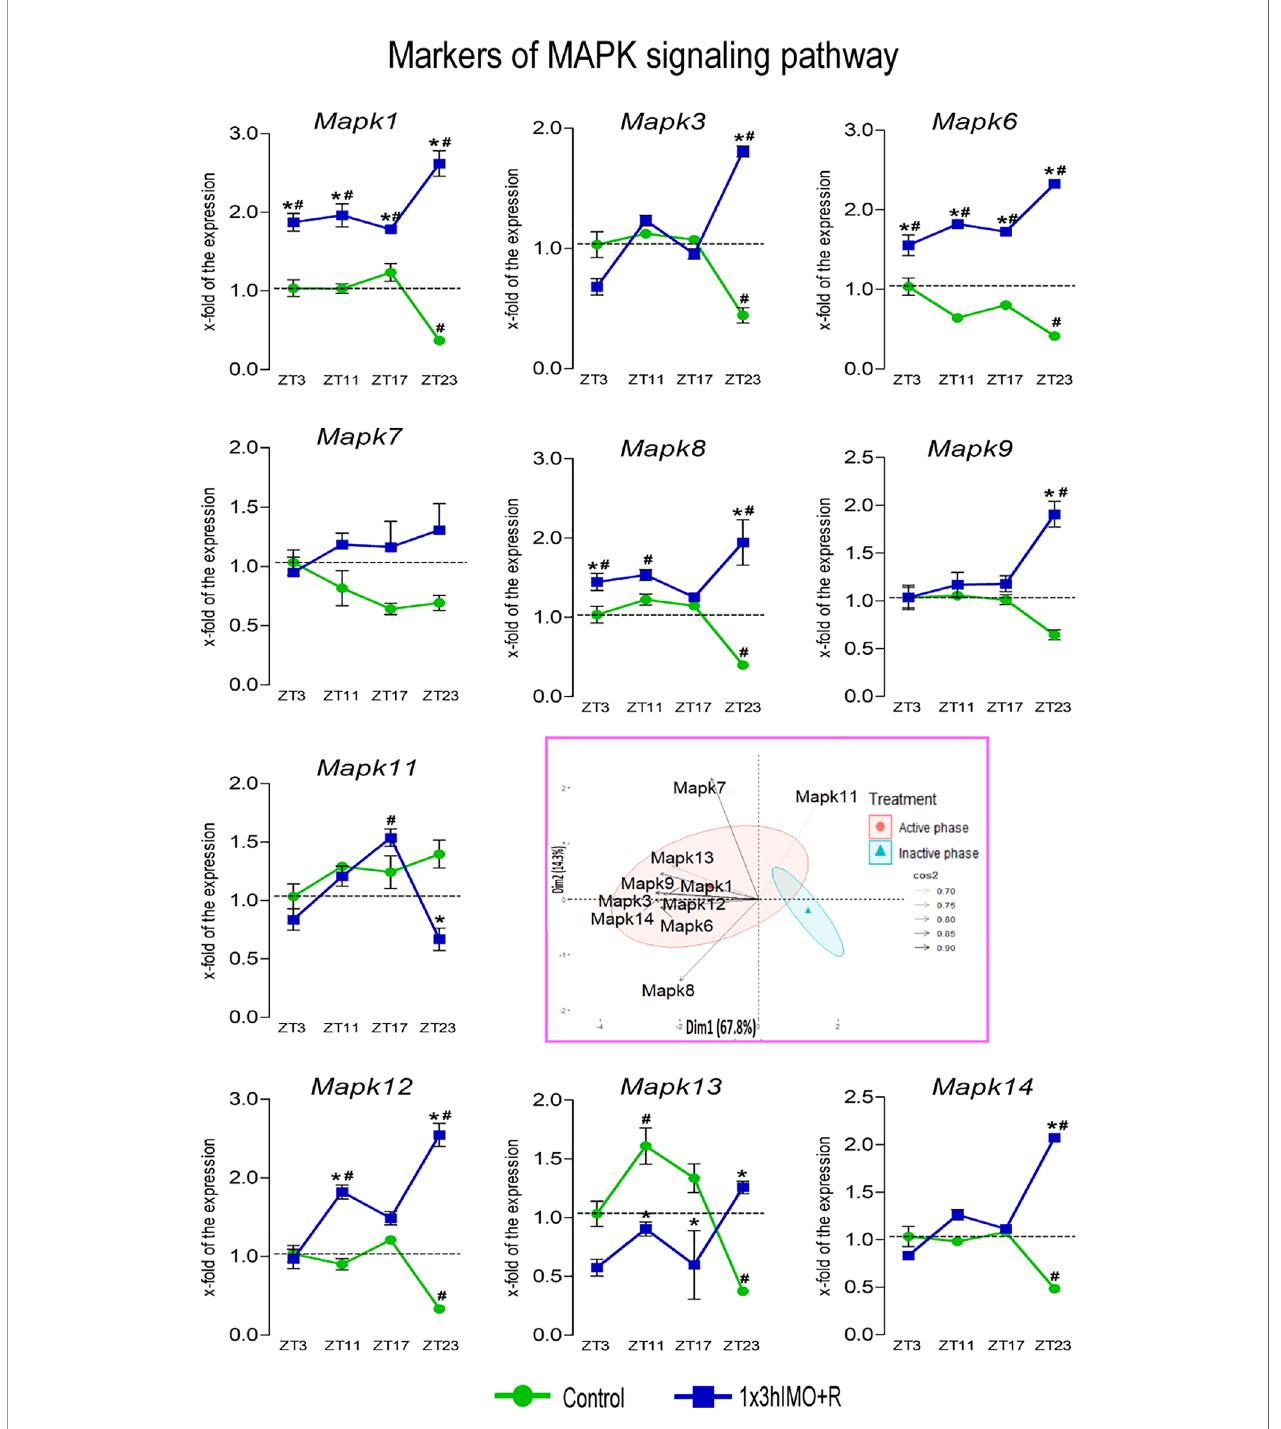
FIGURE 9 | Transcription of markers of MAPK signaling regulating mitochondrial dynamics and functionality as well as spermatozoa number and functionality is changed in spermatozoa of acutely stressed adult rats in a time-dependent manner. Isolated RNA from spermatozoa of undisturbed and stressed rats was used for the analysis of the transcriptional pro fi le of markers of the MAPK pathway. PCA of markers of the MAPK signaling pathway on active/inactive phase; Dim1 and Dim2 represent the fi rst two PCs and % of the retained variation. Cos2 estimates the qualitative representation of variables ( Supplementary Table S3 ). Data are presented as green dots connected with a green line for the control group, and blue squares connected with a blue line for the 1x3hIMO group, and are mean ± SEM values of two independent in vivo experiments. Statistical signi fi cance was set at p < 0.05: * vs. the control group of the same time point, # vs. the control group of ZT3 time